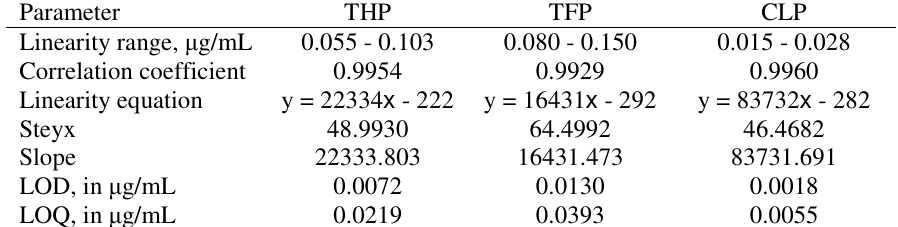
Table 3 . Predication linearity plot results and LOD, LOQ